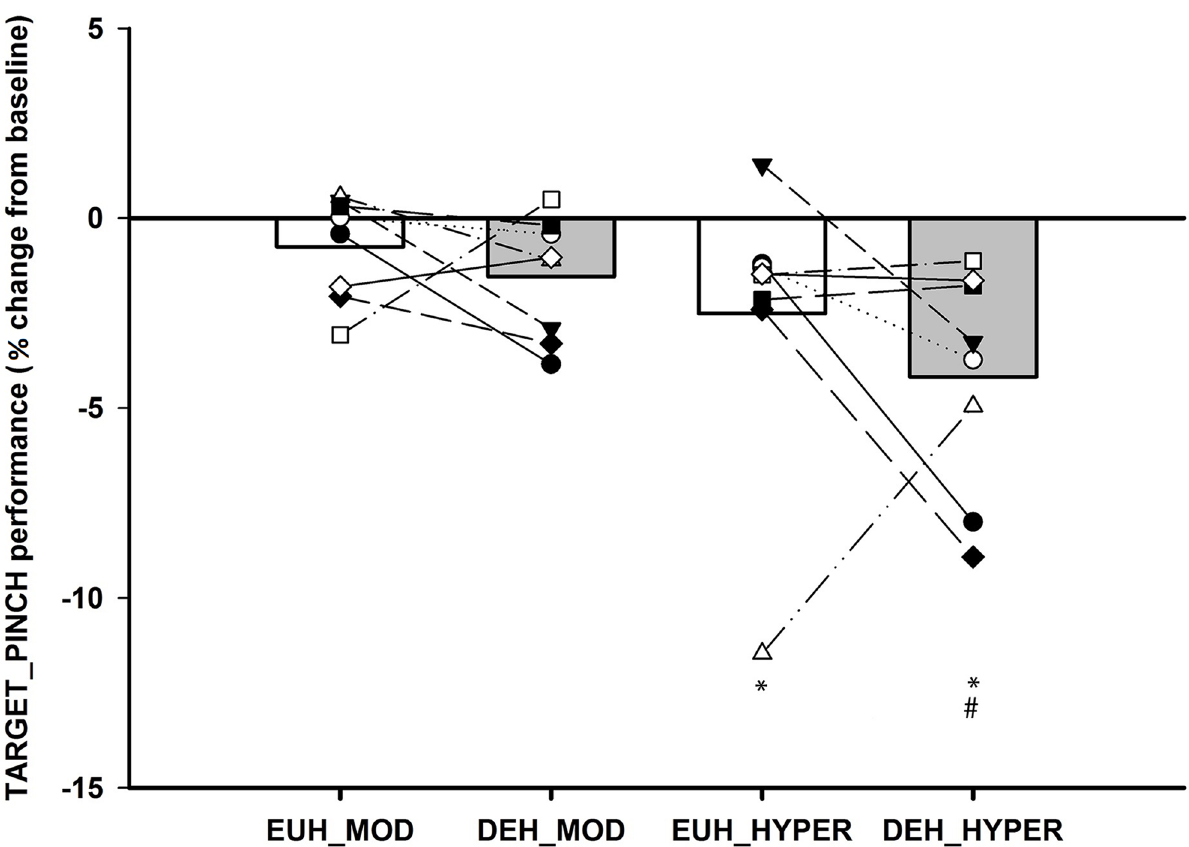
Fig 3. TARGET_PINCH performance score. Individual and mean changes in TARGET_PINCH performance with white bars representing euhydration (EUH: MOD and HYPER) and gray bars the dehydration session (DEH: MOD and HYPER). Values are expressed in percentage change from BASELINE (BASELINE expressed as 0) and individual participant changes in each condition and session. (cid:3) Significantly different from BASELINE, # Significantly different from MOD (P < 0 . 05) .